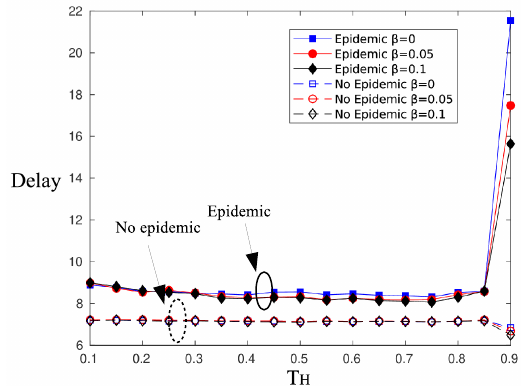
Figure 9. Effect of epidemic mechanism on delay.